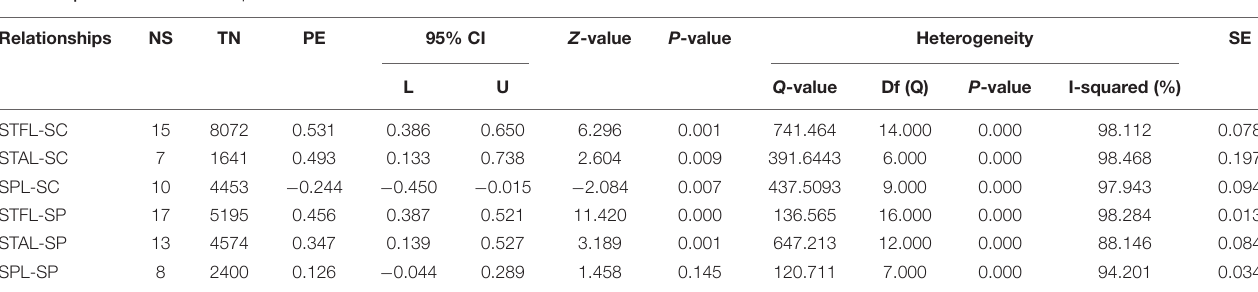
TABLE 5 | Test results of model path